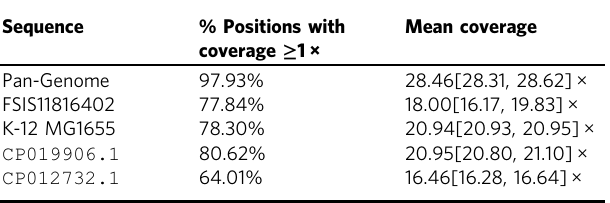
Table 1 Read coverage metrics for the E. coli